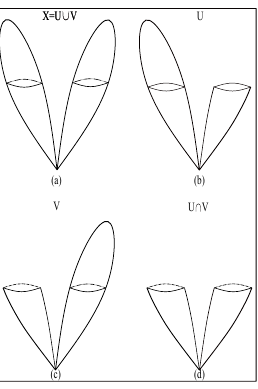
Figure A1. Open sets U and V for computing the cohomology group H 2 ( X ) .